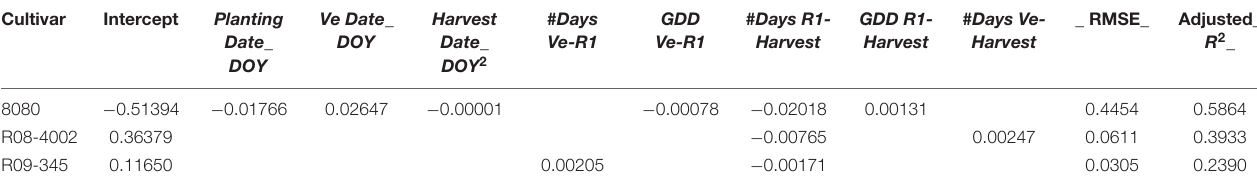
TABLE 2 | Stepwise regression coefficients of cultivar response to Edamame Harvest Quality Index ( EHQI ) based on phenological and thermal functions for three edamame cultivars subjected to three planting dates and up to eight harvest dates between stages R5.8 and R7 planted in two Arkansas locations over 2 years. Cultivar Intercept